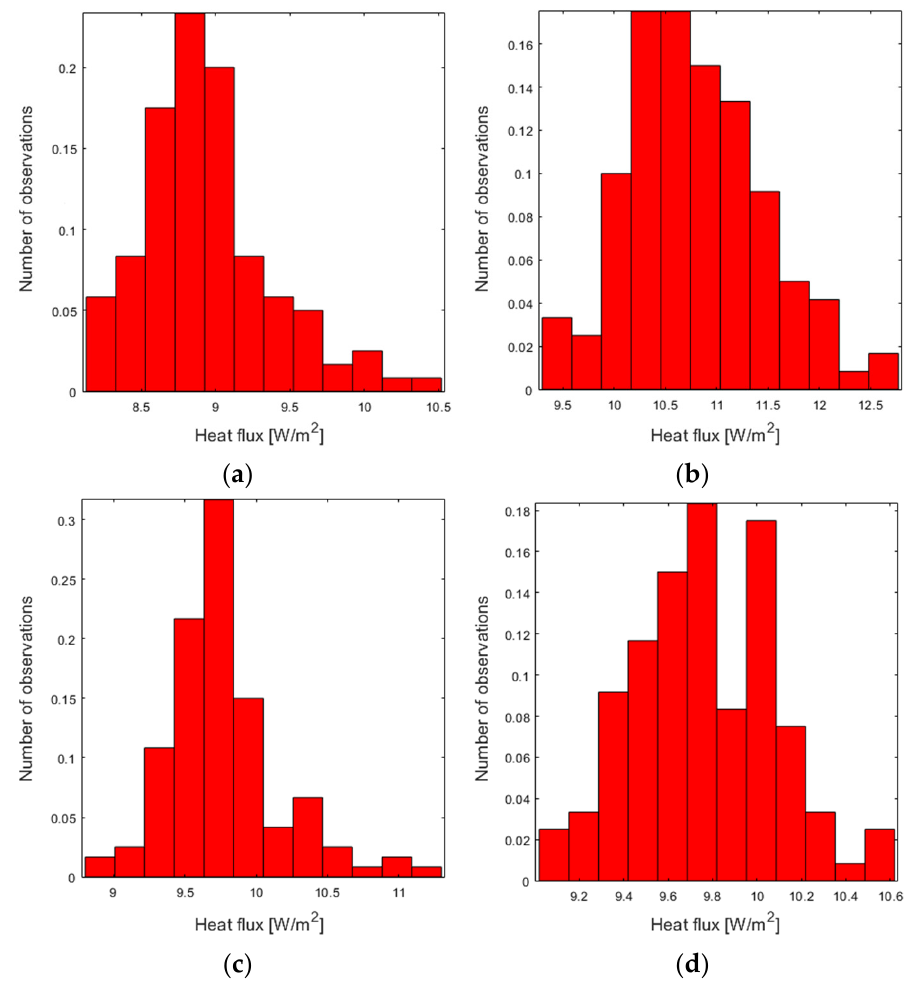
Figure 6. Heat flux histograms for sensor signals: ( a ) q 9 , ( b ) q 10 , ( c ) q 11 , ( d ) q 12 .